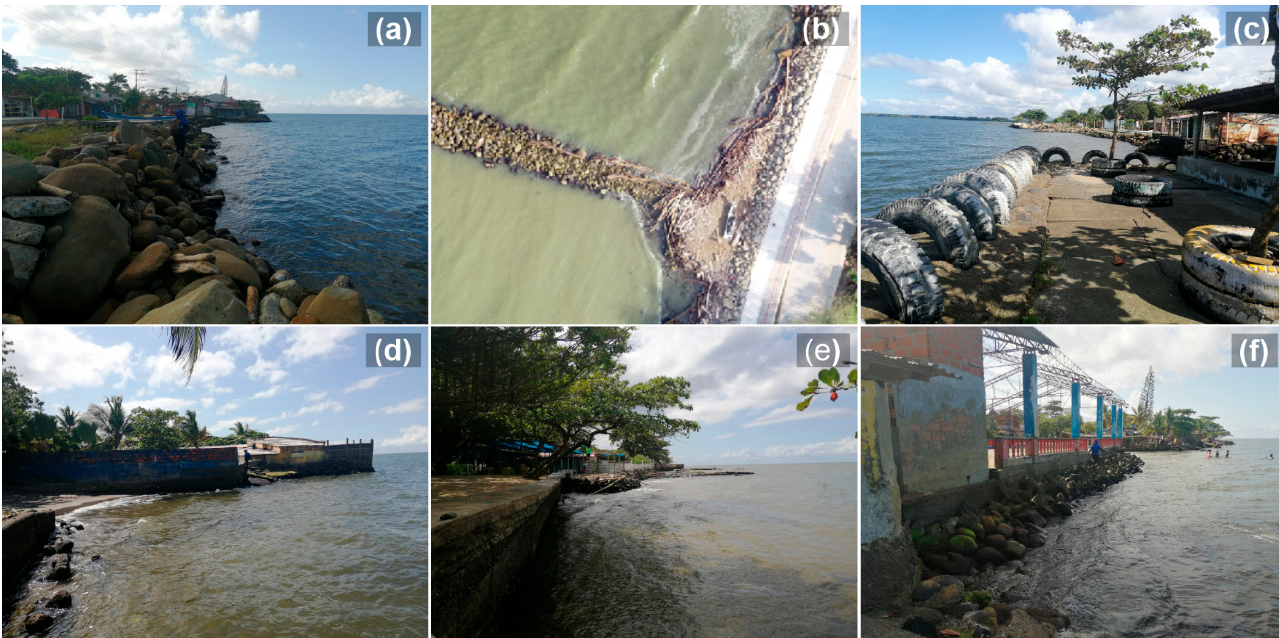
Figure A2. Types of artificial coastal protection structures associated with Table A1: ( a ) Rock revetment (structure 2); ( b ) Rocky groin (structure 4); ( c ) Seawall + Tires (structure 12); ( d ) Pentapod groin (structure 31); ( e ) Retaining wall (structure 20); ( f ) Rock + pentapod revetment (structure 13).